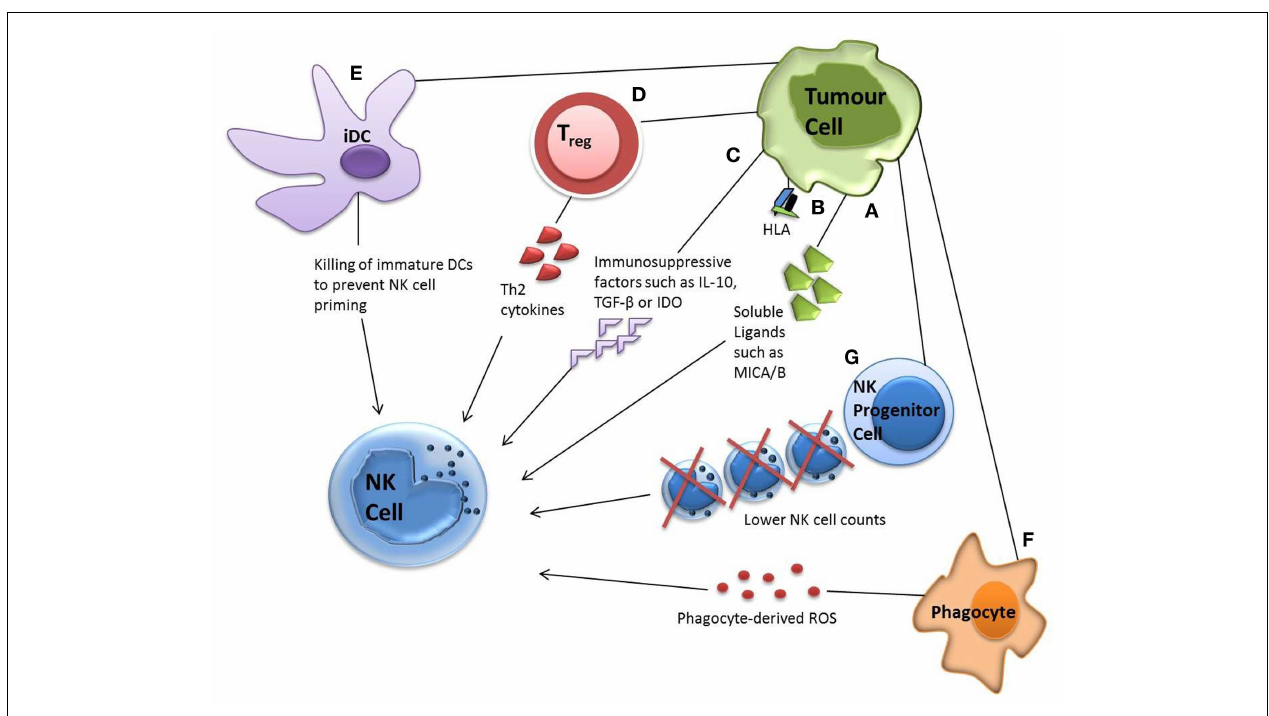
include (D) activation of inhibitory regulatoryT cells (E) dendritic cell killing and (F) phagocyte-derived inhibitory cytokines.Tumor cells have also been shown to decrease the number of NK progenitor cells (G) , hence lowering NK cell